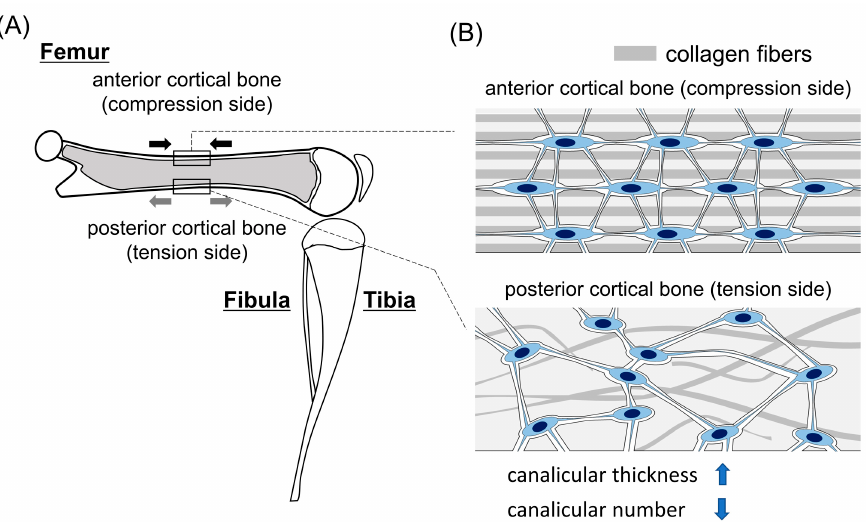
Figure 1. Differences in lacunocanalicular structure between the compression and tension sides of femoral cortical bone: ( A ) A schematic lateral view of the hindlimb of mice. The femur is shown as a sagittal section. Under physiological posture and movement, the anterior and posterior cortical bones receive compression (black arrows) and tension (gray arrows), respectively, in the femur. ( B ) The lacunocanalicular structure of anterior and posterior cortical bones at diaphysis of the femur. Anterior cortical bone has more organized collagen fibers and lacunae, and thinner and more canaliculi than posterior cortical bone.